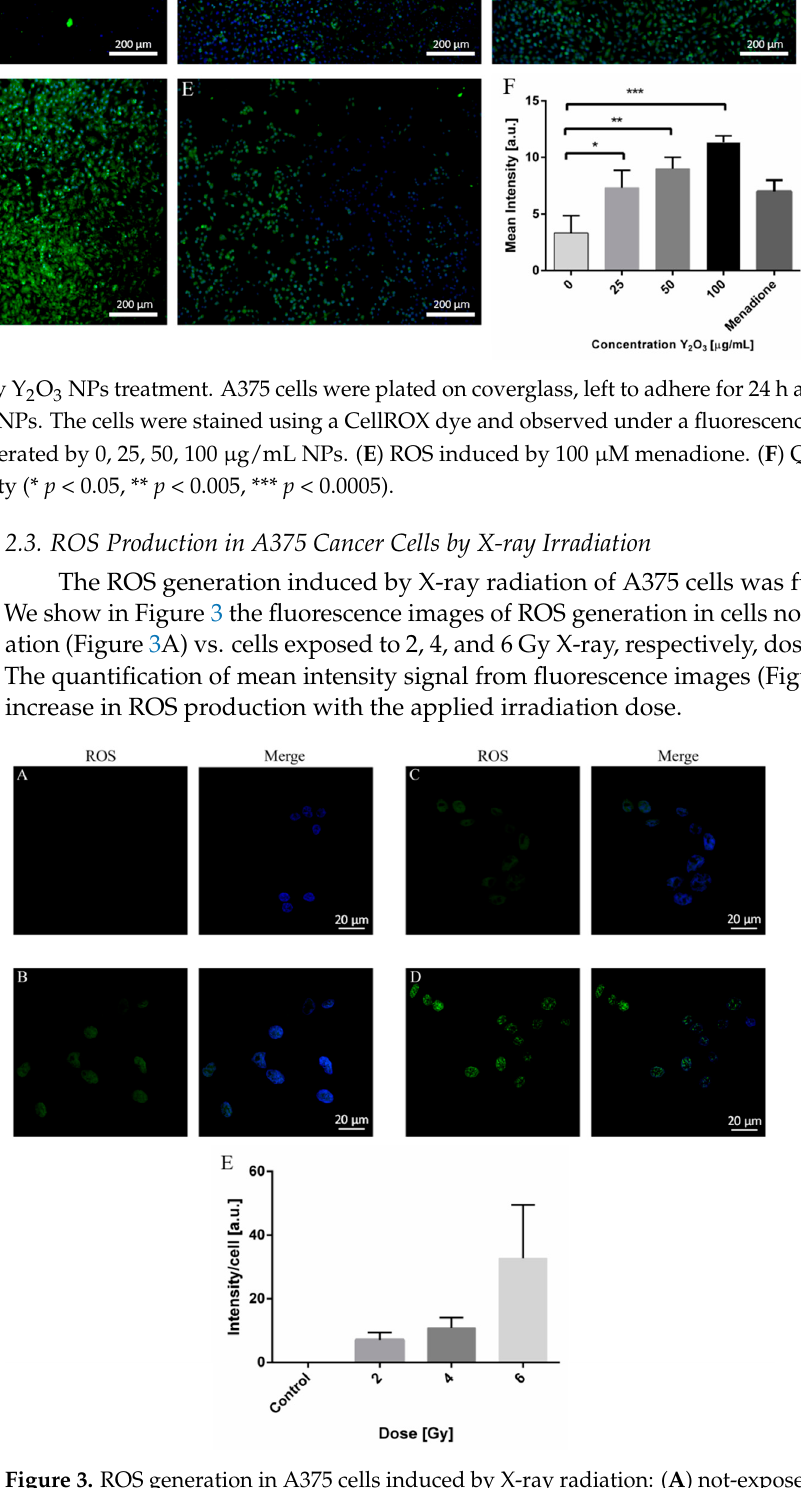
Figure 4. Mitochondrial morphological changes in A375 cells after X-ray radiation: ( A ) not-exposed ( ● ) vs. exposed cells to ( B ) 2 Gy ( ■ ), ( C ) 4 Gy ( ▲ ) and ( D ) 6 Gy ( ▼ ). ( E ) Quantification of each cell fluorescence from A–D by ImageJ (the number of symbols for each dose represents the number of cells).